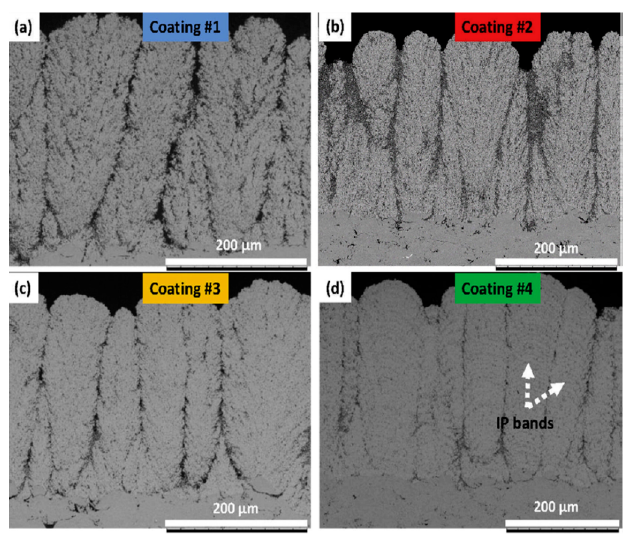
Figure 6. Cross-sectional SEM micrographs showing distinct columnar ytrria stabilized zirconia (YSZ) thermal barrier coating (TBC) microstructures deposited by SPS process [25].